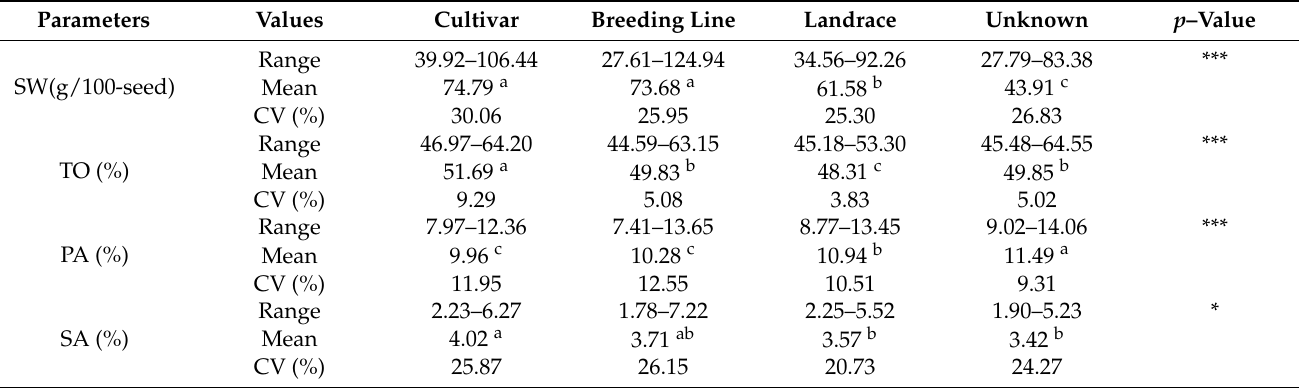
Figure 1. Total oil content, and individual and total fatty acid contents according to 100-seed weight groups. Group I, Group II, Group III, Group IV, and Group V represent the genotypes have a 100-SW of 25 – 45 g, 45 – 65 g, 65 – 85 g, 85 – 105 g, and 105 – 125 g, respectively. TO = total oil, PA = palmitic acid, SA = stearic acid, OA = oleic acid, LA = linoleic acid, AA = arachidic acid, OL = oleic acid to linoleic acid ratio, SFA = total saturated fatty acid, UFA = total unsaturated fatty acid. Different letters indicate significant differences between groups ( p < 0.05). Table 2. Seed weight, total oil content, and individual and total fatty acid contents of the cultivar ( n = 17), breeding line ( n = 151), landrace ( n = 61), and unknown ( n = 72)